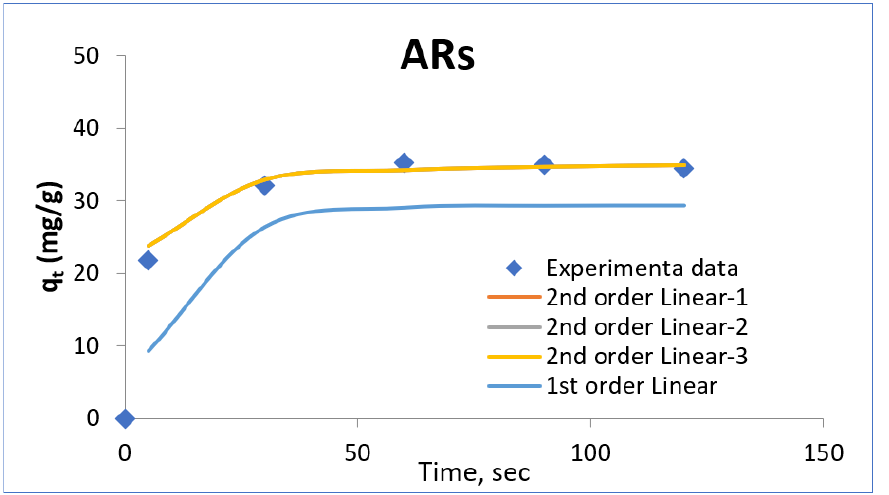
tion of oil onto ABs. of oil onto ABs.